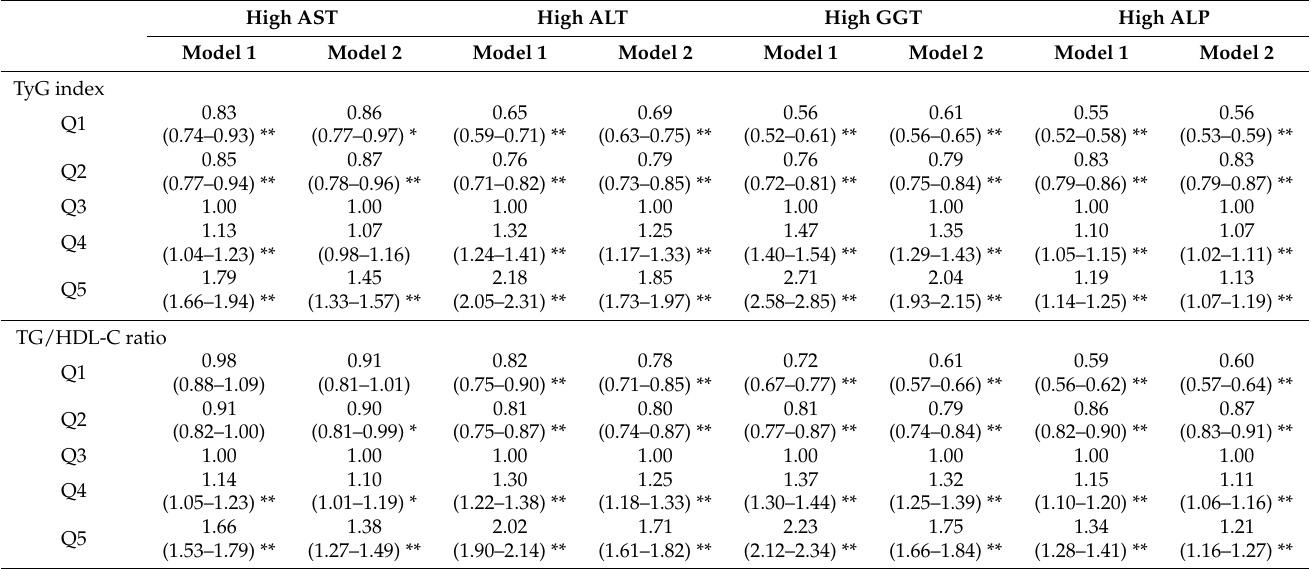
Table 2. Multivariable adjusted logistic regression for abnormal liver function tests in different quintiles of TyG index and TG/HDL-C